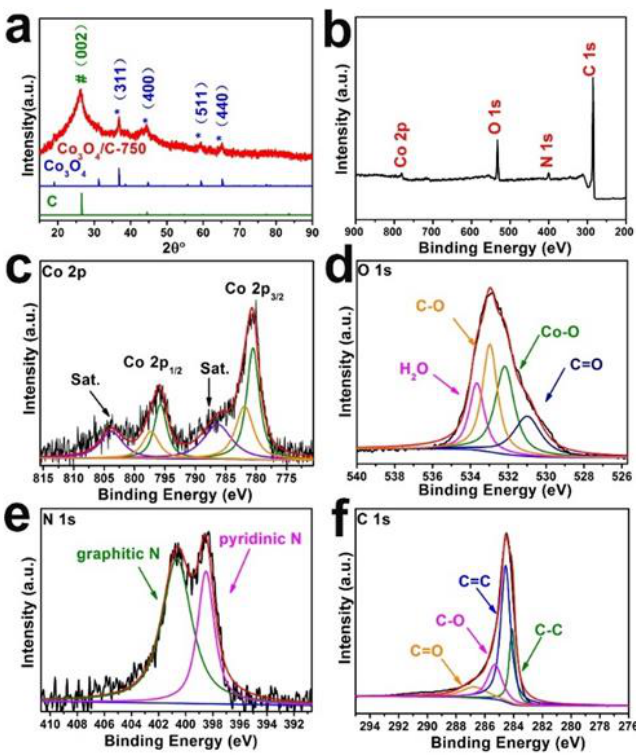
Figure 2. ( a ) XRD patterns of Co 3 O 4 /C−750, Co 3 O 4 , and graphite (red, blue and green traces, respectively, peaks labeled with * are attributed to Co 3 O 4 and peak labeled with # is ascribed to C). XPS characterizations of Co 3 O 4 /C−750 for ( b ) survey spectrum, high - resolution analysis of ( c ) Co 2p, ( d ) O 1s, ( e ) N 1s and ( f ) C 1s.